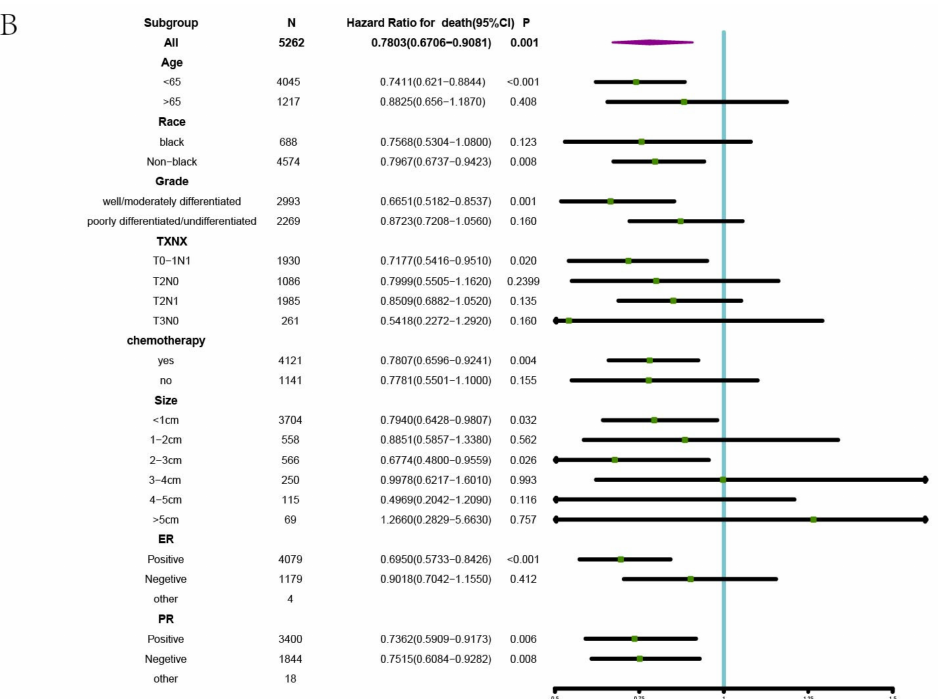
Figure 3. Subgroup analysis for OS and BCSS for stage II patients. ( A ) Forest map for OS ( B ) Forest map for BCSS.